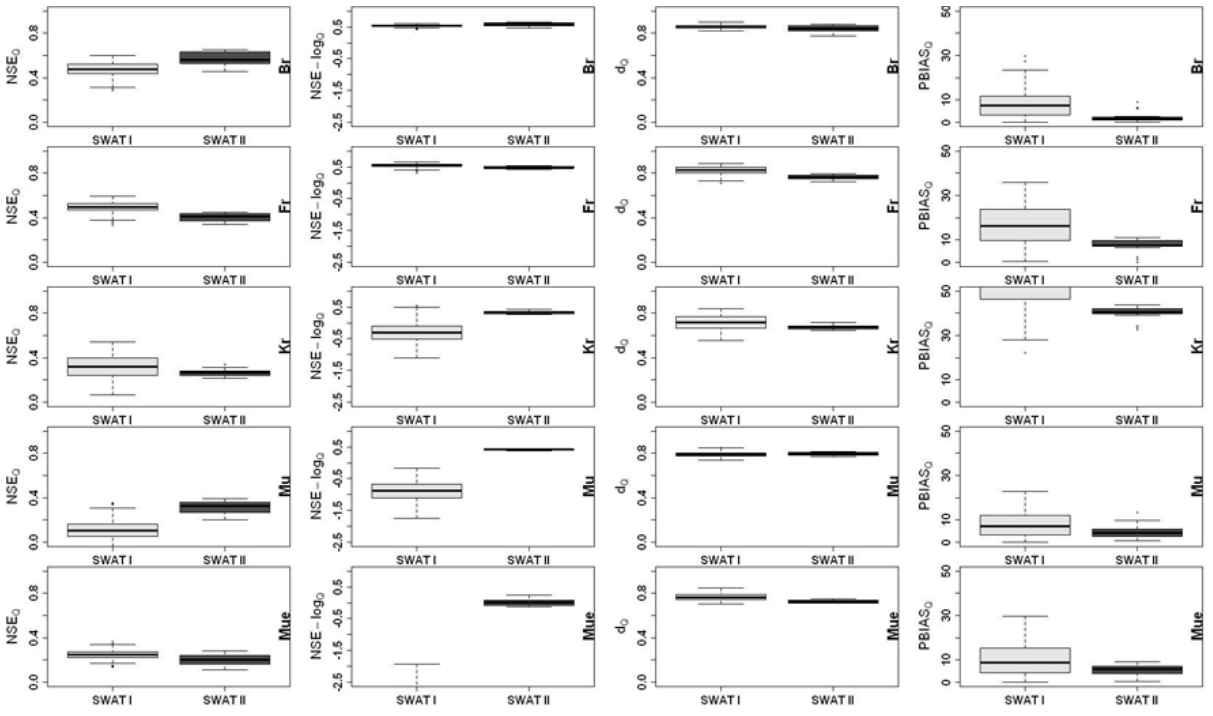
Fig. 3. Performance of the parameter ensembles of SWAT I and SWAT II for the goodness-of-fit measures concerning discharge; the respective gauging stations are indicated with Br = Bruchenbr¨ucken, Fr = Friedberg, Kr = Kransberg, Mu = Muschenheim, Mue = M¨unster.